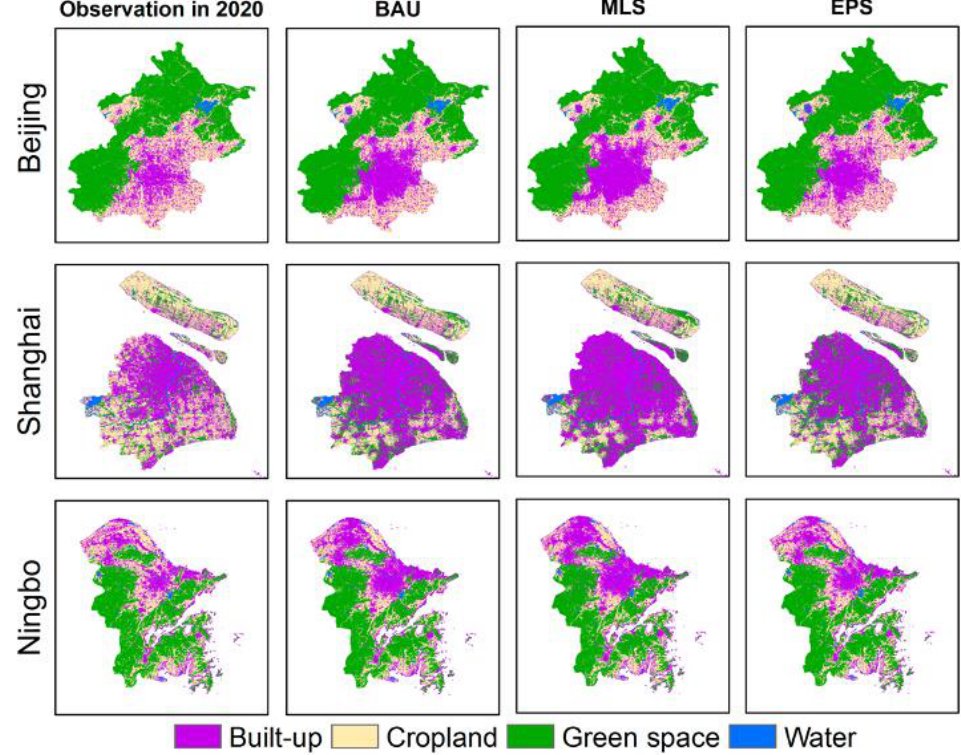
Figure 3. Land-cover observation results for 2020 and simulated land-cover maps for 2030 under three scenarios for three cities in China.